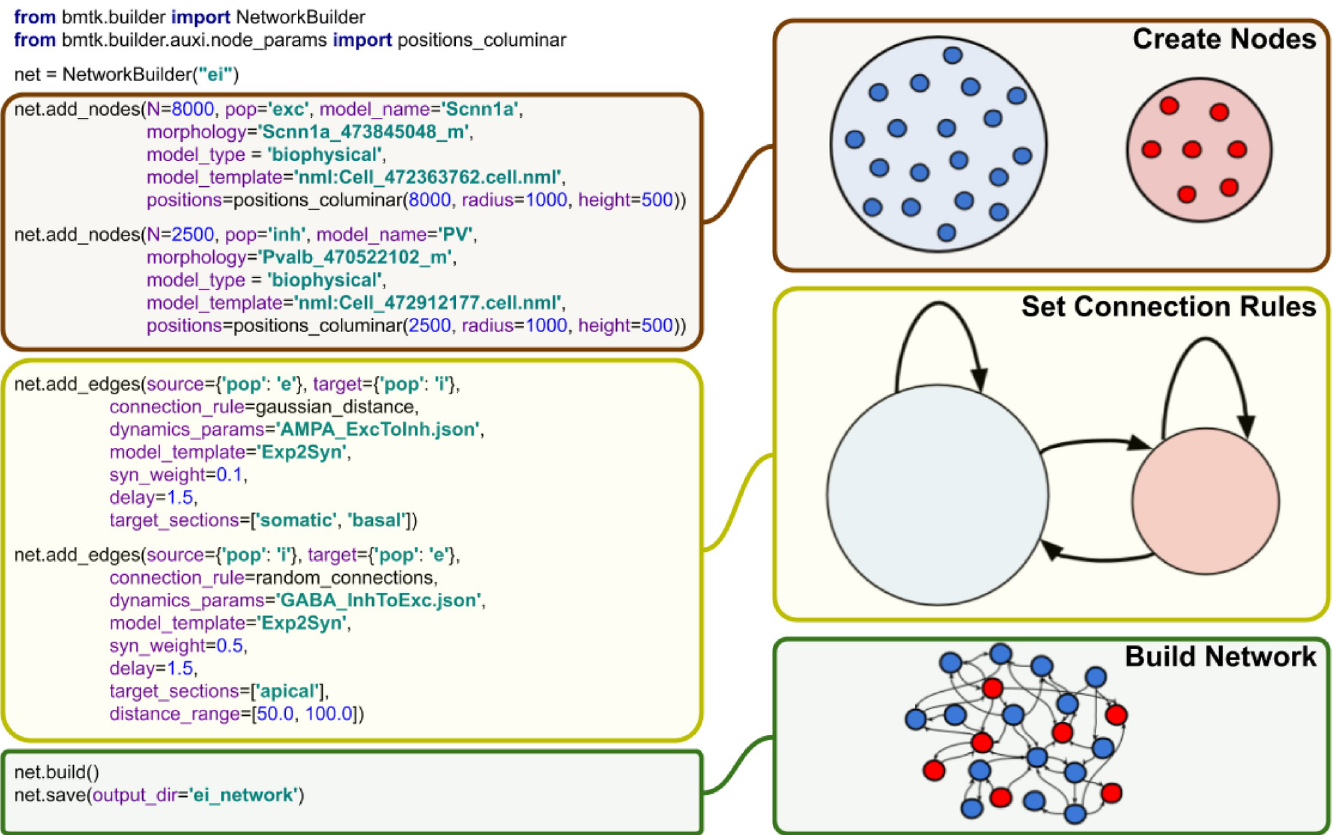
Fig 3. BMTK Builder. The Builder module is used to design and instantiate network models. On the left, examples of the Python commands used in BMTK Builder are presented. Note that in this simple example it is assumed that user-defined connection functions “gaussian_distance” and “random_connections” are employed. The purpose of these commands is illustrated schematically on the right. The main stages of model building workflow are defining the nodes and their attributes, defining the connection rules, and then instantiating and saving the